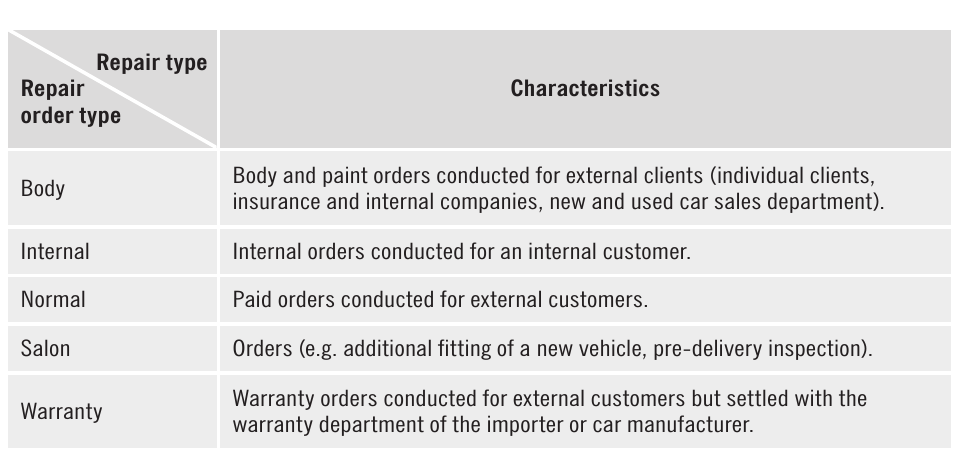
Table 4. Characteristics of repairs types (types of repair orders) conducted in the analyzed